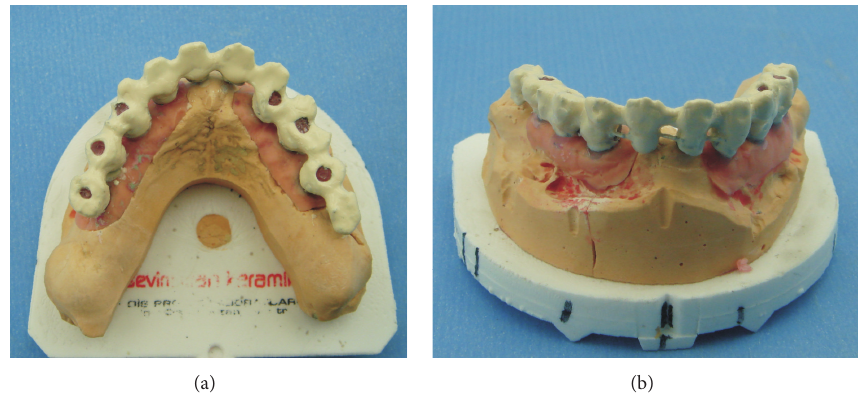
Figure 10: (a) Occlusal and (b) frontal view of the first composite layer that is bonded to the metal substructure.